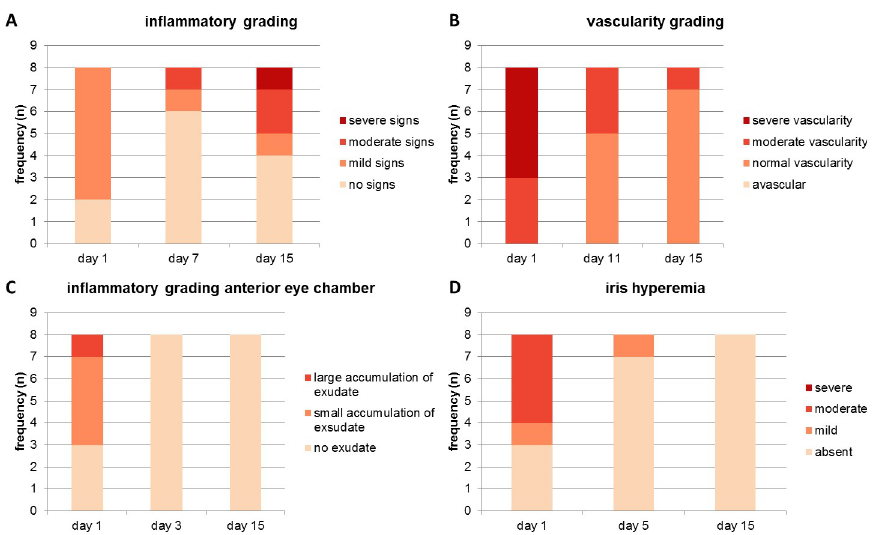
Fig 6. Results of the direct ophthalmoscopy and slit-lamp examination. Graphs A-D show the results of ophthalmic examination including the four chosen categories and their classification (presented in 2.5.2, n = 8). For all categories, the first (1) and final day (15) of the observation period were considered. Concerning the inflammatory grading at the implant site, the results of day 7 presenting the half-time stage of the experiment are shown. For graphs B-D, the middle column presents the time point where no statistically significant difference in the distribution of the examination degree between all animals was detectable according to the permutation test.